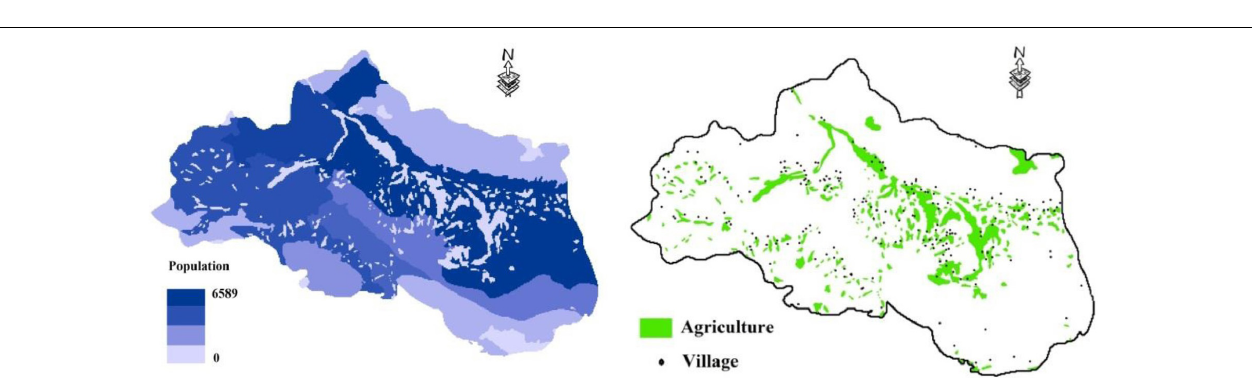
FIGURE 1 | Location map of the study area and its different rangeland types.